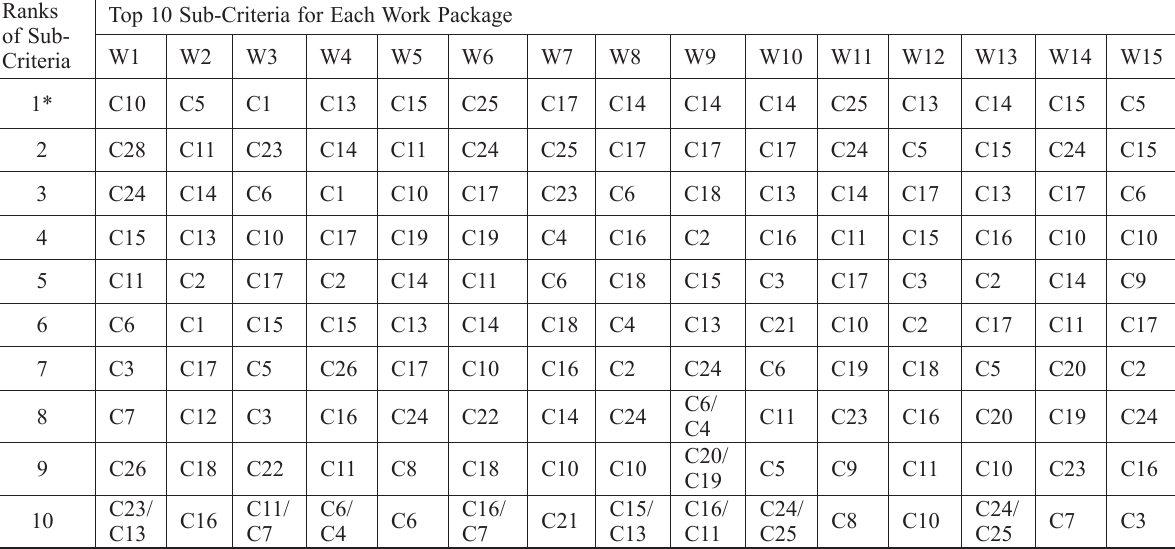
Table 2. Top ten sub-criteria with respect to all 15 work packages Ranks of Sub-